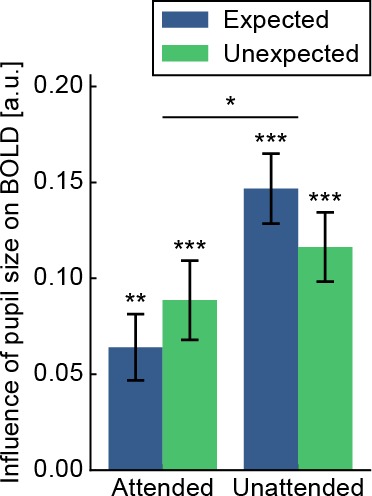
Pupil dilation influences BOLD responses in V1.Displayed are the parameter estimates of the influence of pupil size on BOLD responses in V1. BOLD responses increase with larger pupil dilations regardless of whether stimuli were attended and expected. However, pupil dilation influenced BOLD responses more when objects were unattended than attended. Whether stimuli were expected or unexpected did not change the association between BOLD and pupil dilation. Error bars indicate within-subject SEM.*p<0.05, **p<0.01, ***p<0.001.